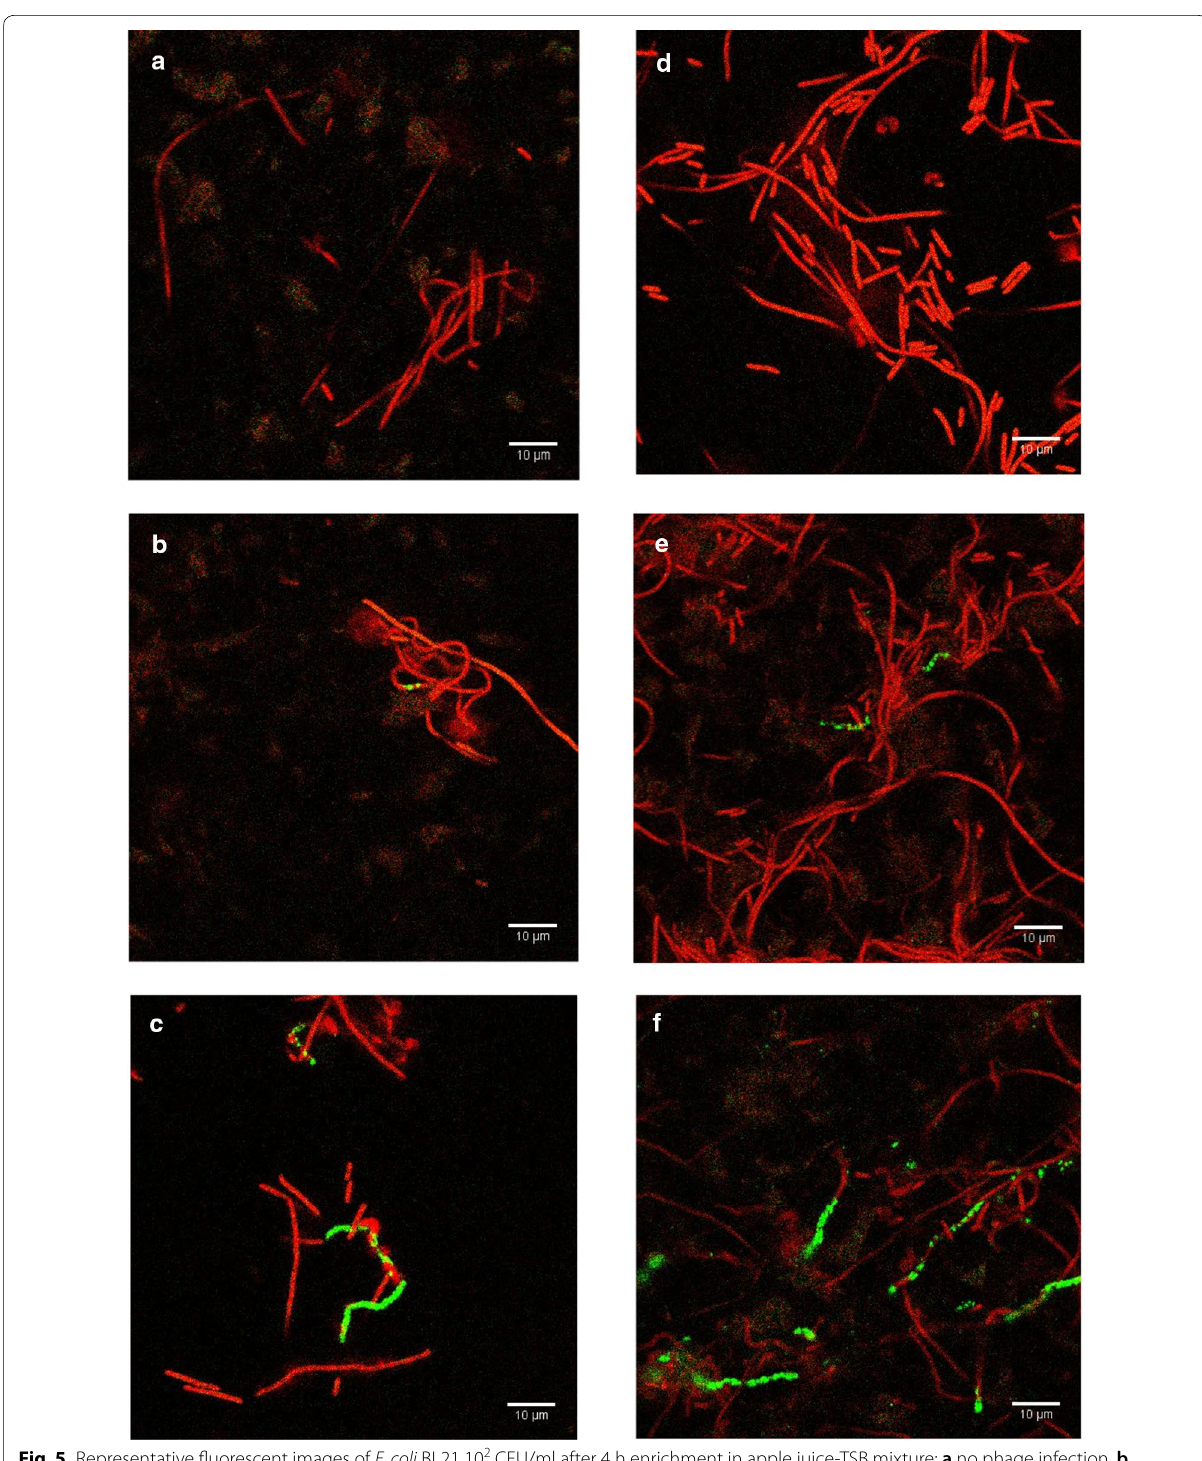
Fig. 5 Representative fluorescent images of E. coli BL21 10 2 CFU/ml after 4 h enrichment in apple juice-TSB mixture: a no phage infection, b after 15 min of T7-ALP infection, c after 30 min of T7-ALP infection. Fluorescent images of E. coli BL21 10 3 CFU/ml after 4 h enrichment in apple juice-TSB mixture: d no phage infection, e after 15 min of T7-ALP infection, f after 30 min of T7-ALP